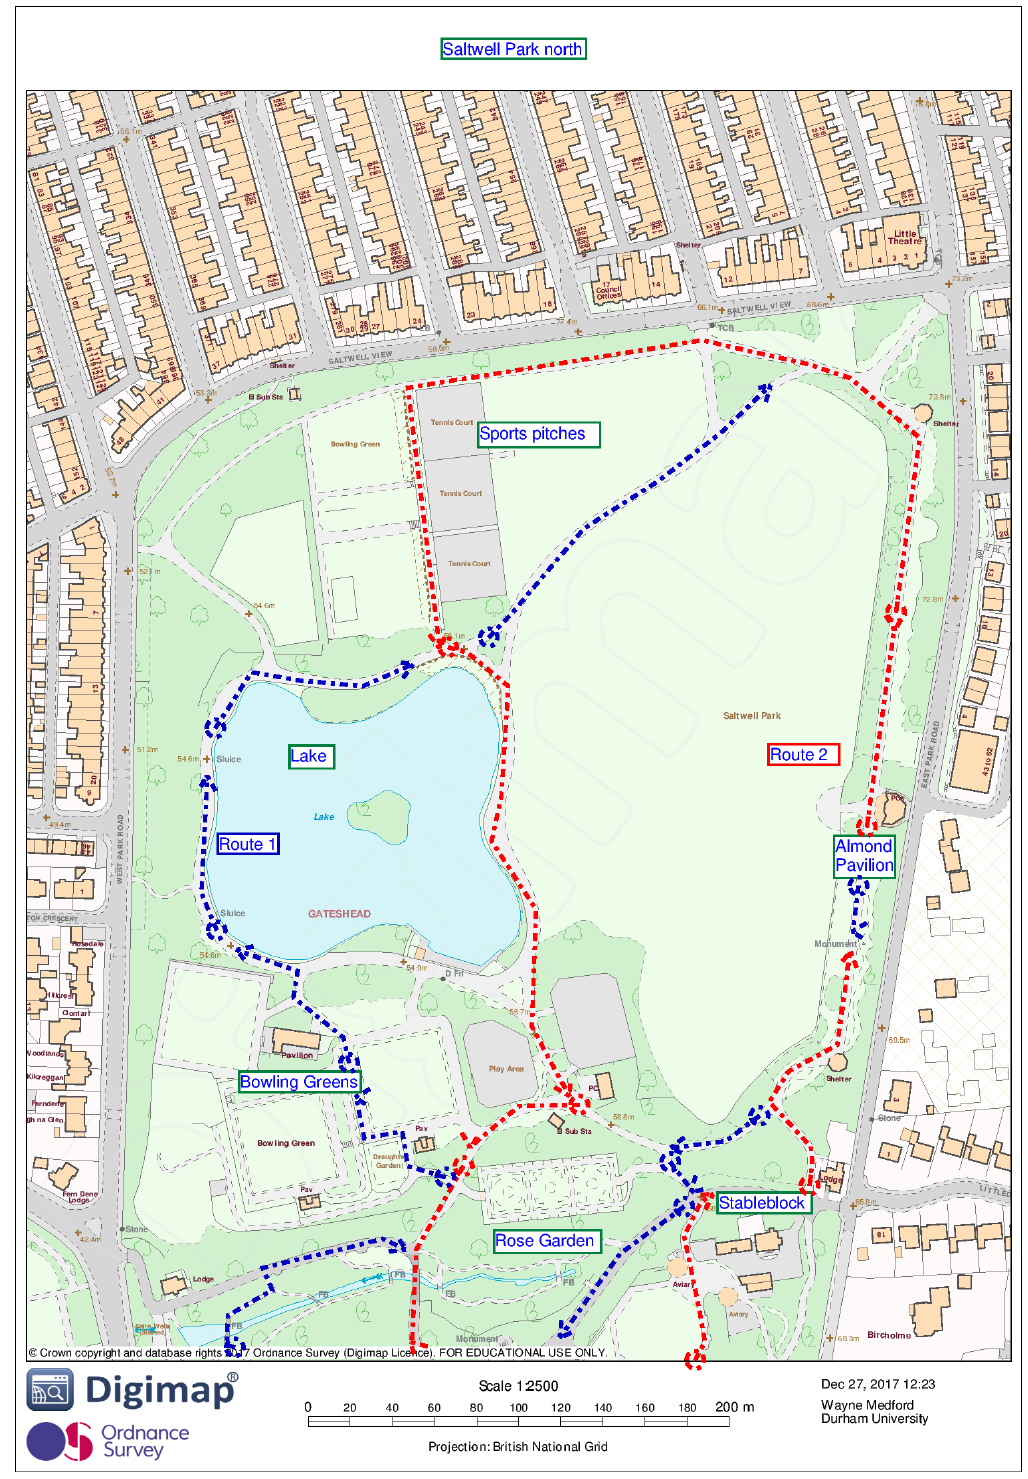
Figure 5. Walking routes through the northern half of Saltwell Park.